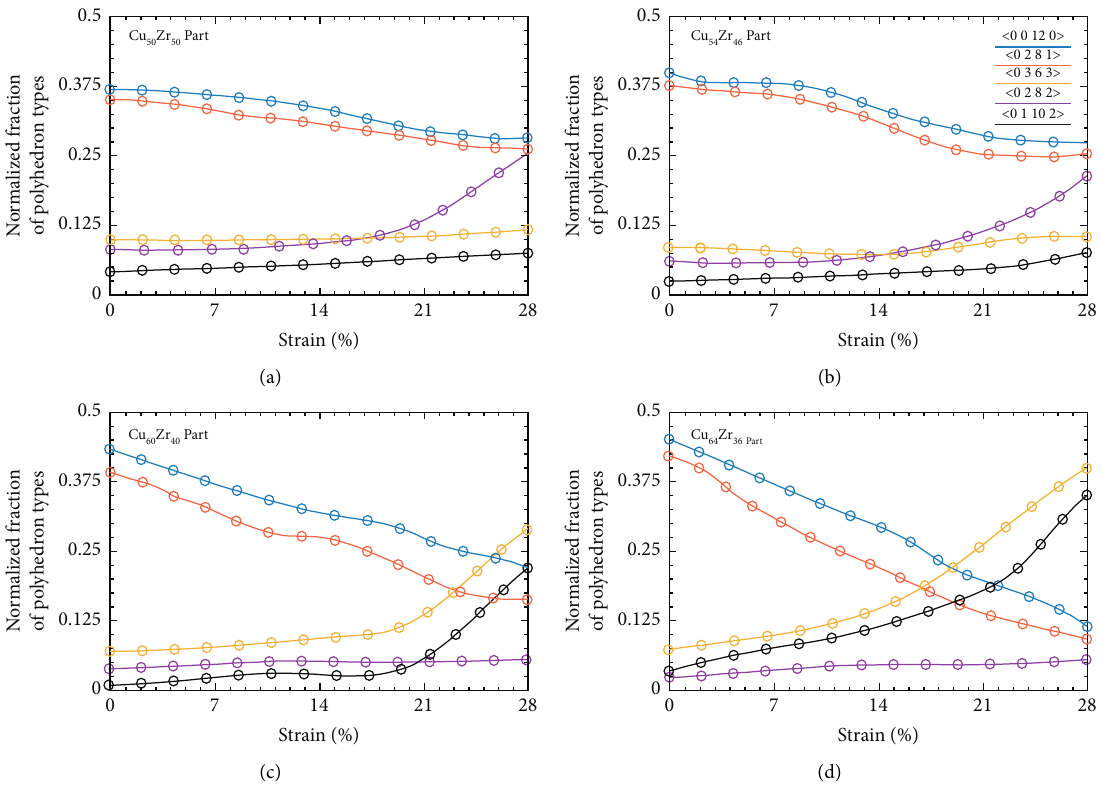
Figure 7: The evolution of polyhedron types during the tensile loading in the MG part of composites fabricated by (a) Cu (b) Cu 54 Zr 46 , (c) Cu 60 Zr 40 , and (d) Cu 64 Zr 36